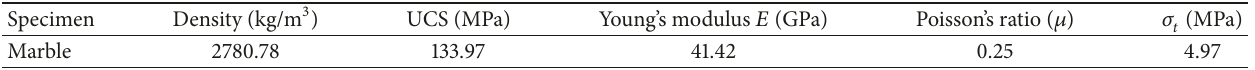
Table 1: Parameters of the marble material.